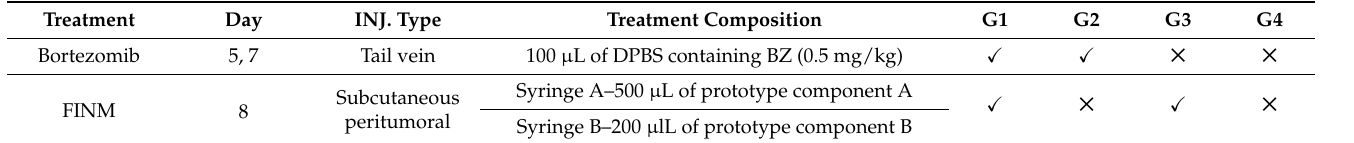
Table 1. Description of the treatment delivered to mice bearing MM tumors (4 treatment